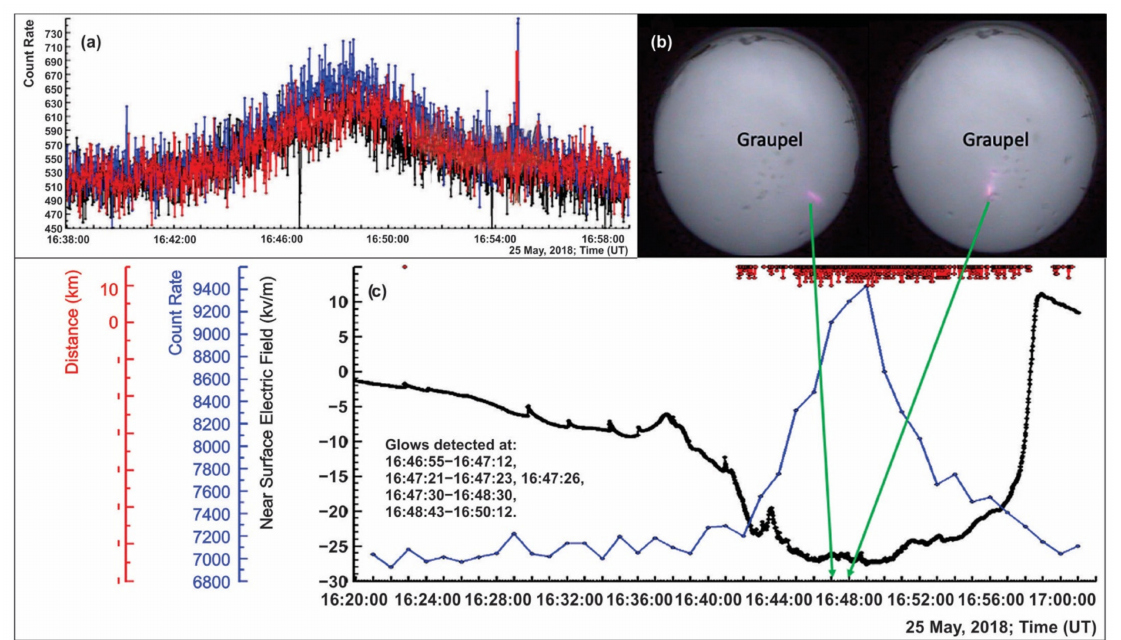
Figure 11. ( a ) Time series of 1 s count rates of 3 cm thick plastic scintillators of STAND1 network, MAKET (black), GAMMA (blue), and SKL (red); ( b ) panoramic camera shots with light spots and graupel fall specks observed at the maximum flux of TGE; ( c ) disturbances of the NSEF measured by EFM-100 sensor located nearby GAMMA surface array (black curve), 1 min time series of count rates of the 3 cm-thick plastic scintillator of STAND3 detector (energy threshold 4 MeV, blue curve), red lines in the upper part of the frame: remote lightning flashes. In the inset to frame ( c ) we indicate the times of glows; by green arrows, we denote the time of two glows that are portrayed in frame ( b